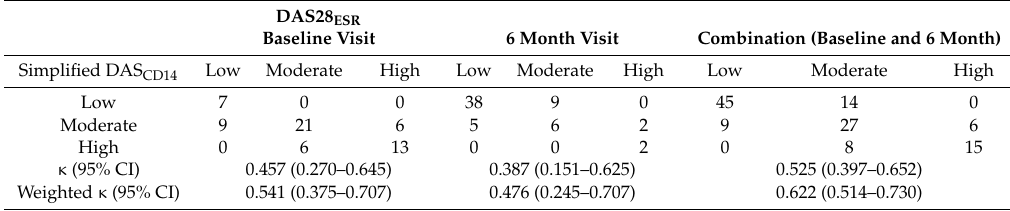
Table 1. Classification of disease activity (low, moderate, or high) according to the simplified DAS CD14 and DAS28